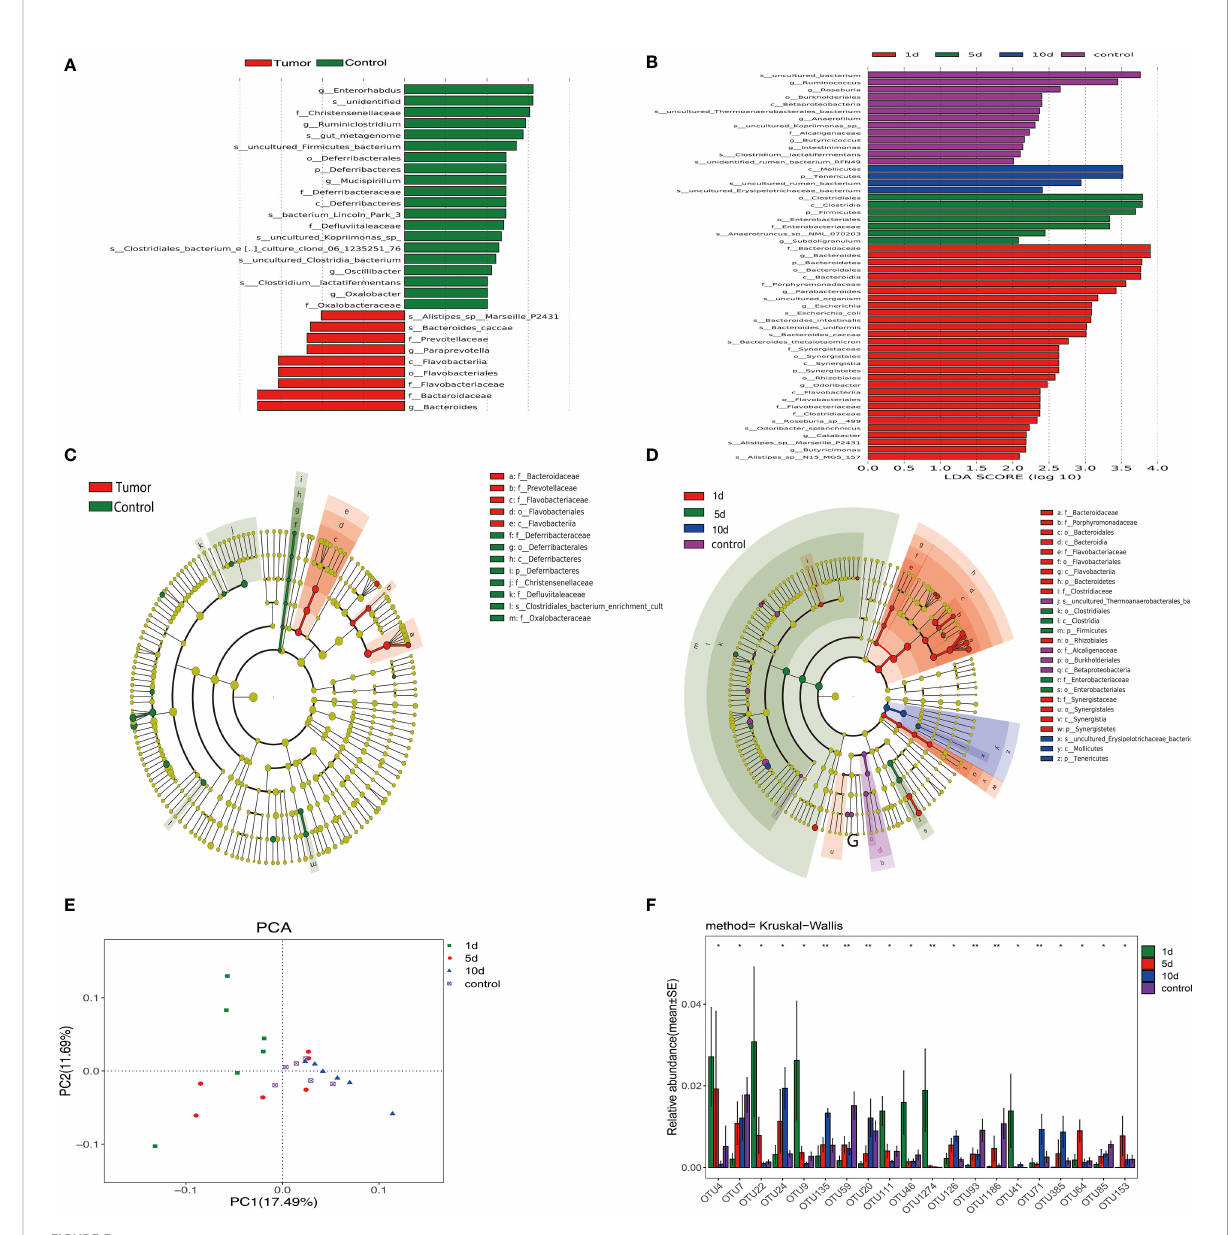
FIGURE 3 Linear discrimination analysis effect size (LEfSe) and linear discriminant analysis (LDA) revealed differences in taxonomic composition in tumor models when compared with HCs, and changes in intestinal micro fl ora composition in tumor models before and after transcatheter arterial chemoembolization (TACE). (A) LDA scores showing differences in models (red) and HCs (green). (B) A cladogram showing taxonomic compositions in models (red) and HCs (green). (C) Bacterial levels in models underwent TACE at different time points and HCs in LDA scores. (D) A cladogram showing different taxonomic compositions in models at different time points and HCs. One day after TACE (red), 5 days after TACE (green), 10 days after TACE (blue), and HCs (purple). (E) Principal component analysis (PCA) of intestinal fl ora in animals undergoing TACE at indicated time points and HCs. (F) Bacterial diversity analyses in groups undergoing treatment. **p <0.01; *p <